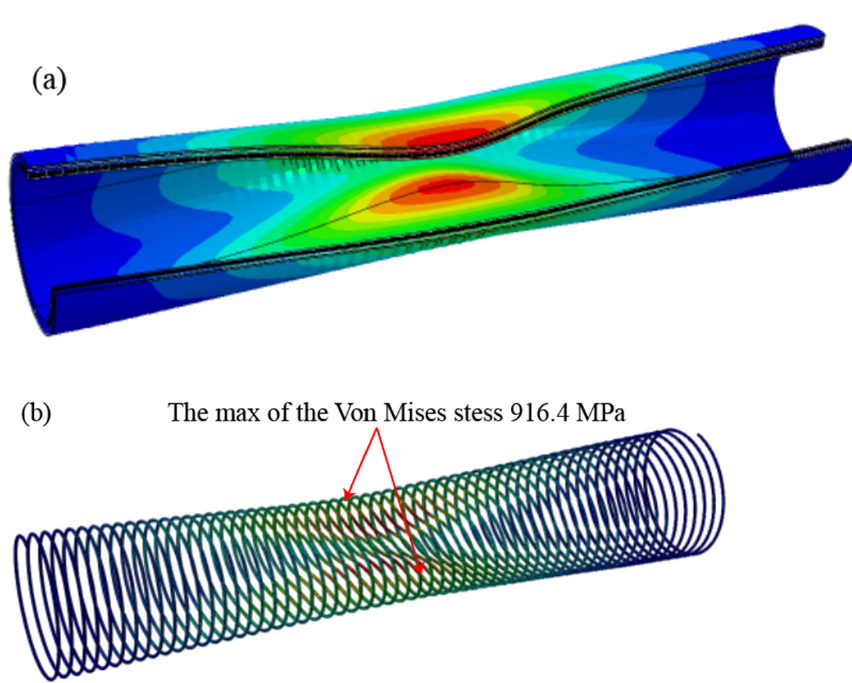
Figure 6. Deformed distribution: ( a ) rubber layers and fiber reinforcement layers; ( b ) steel helix wire.